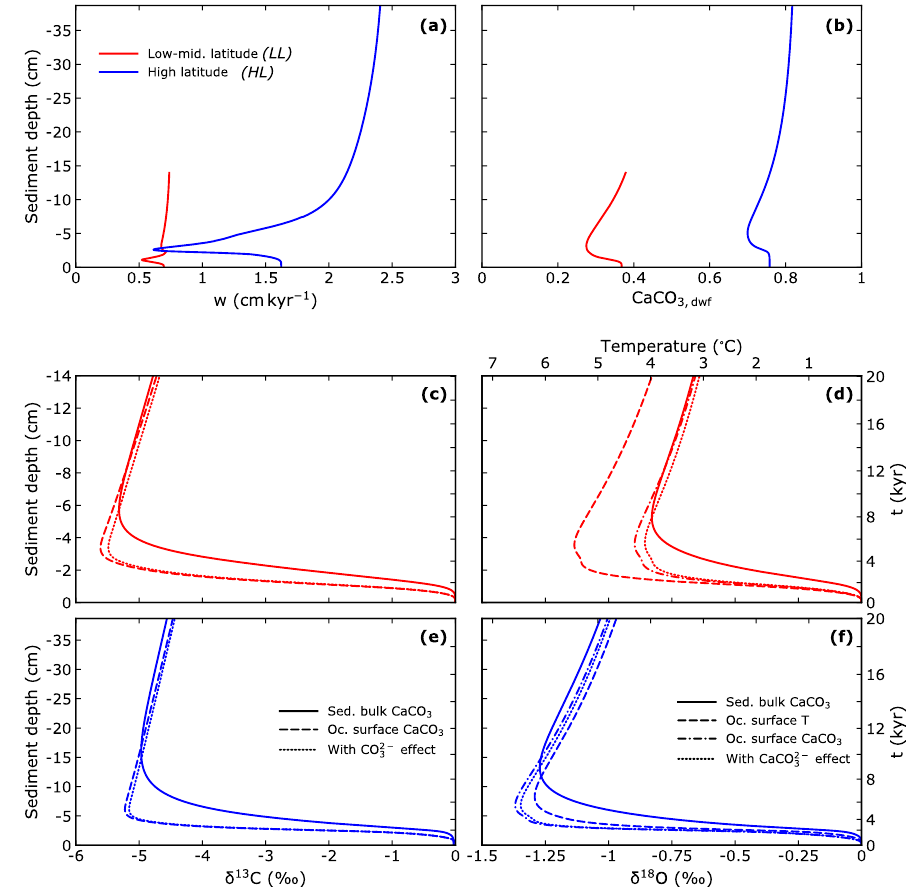
Figure 13. Comparison of bulk carbonate results from model synthetic ocean sediment cores at 3000m depth with ocean surface-layer properties for the simulation of Fig. 11. Low–mid-latitude (LL) and high-latitude (HL) results are plotted with red and blue lines, respectively, and the methane input has δ 13 C = − 40‰. (a) Burial (downward) velocity relative to the base of the bioturbated sediment layer vs. synthetic sediment depth (SSD). SSD is referenced to zero at the start of the simulation and increases downcore by convention, (b) carbonate dry weight fraction vs. SSD, (c) LL bulk carbonate δ 13 C excursion vs. LL SSD (solid line). Also shown are the δ 13 C excursions in biogenic carbonate in the LL ocean surface layer (dashed line) and this δ 13 C including the correction for change in surface-layer CO 2 − et al., 1997), both plotted vs. simulation time (right side y axis). The time axis is “stretched/squeezed” relative to the SSD axis, a product of time-varying burial rates, (d) LL bulk carbonate δ 18 O vs. LL SSD (solid line). Also shown are (1) ocean surface-layer temperature anomaly (dashed line) on a temperature scale (top x axis) related to the oxygen isotope scale (bottom x axis) using temperature dependence of biogenic carbonate δ 18 O (Bemis et al., 1998), (2) δ 18 O in biogenic carbonate produced in the LL ocean surface layer (dashed-dot line) that includes the water δ 18 O excursion (see Figs. 7–9i) and (3) this δ 18 O including the correction for change in surface-layer CO 2 − et al., 1997), all plotted vs. simulation time, (e) as (c) but for the HL ocean and sediment, (f) as (d) but for the HL ocean and